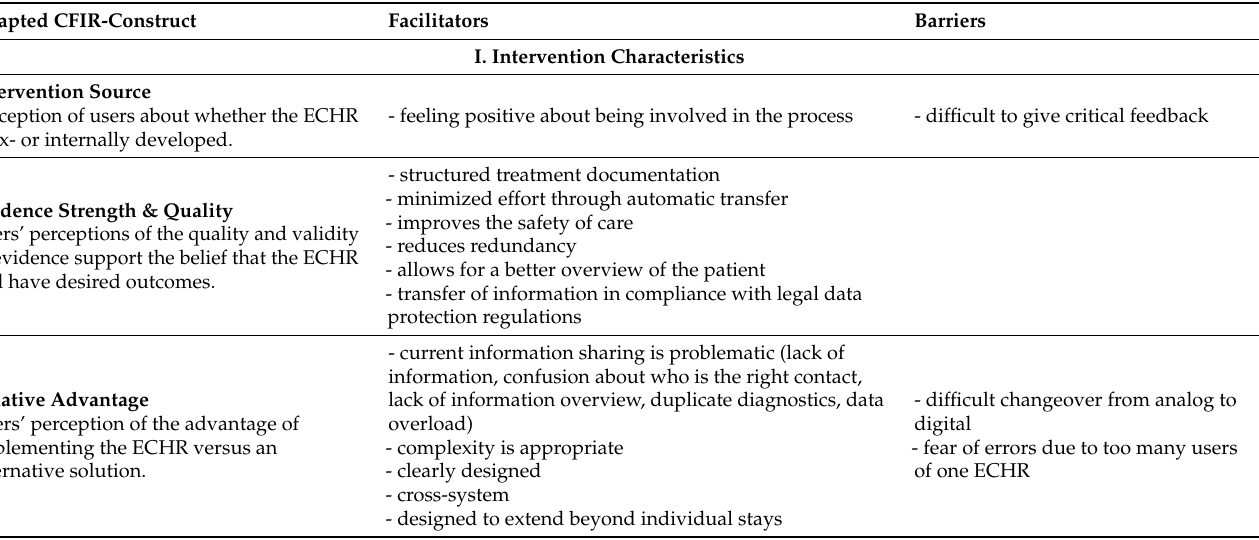
Table A1. Facilitators of and barriers to implementation of a shared electronic cross-facility health record based on CFIR